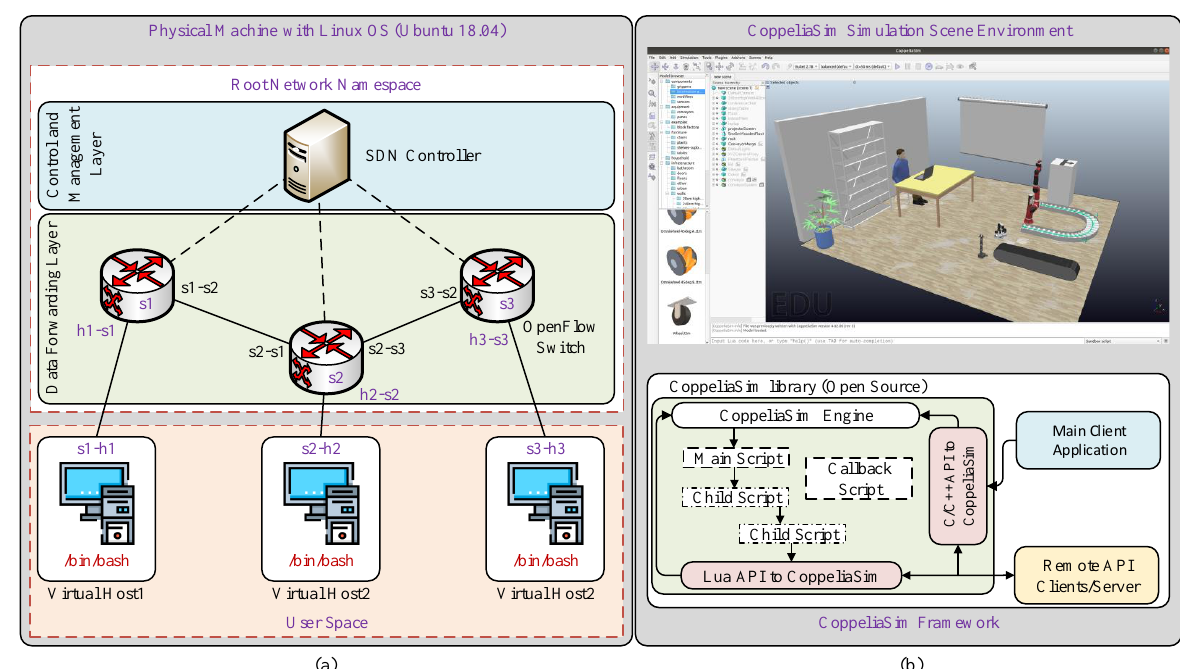
Figure 5. Overview of the basic framework for Mininet and CoppeliaSim. ( a ) represents the Mininet network emulator with Open vSwitch and SDN based OpenFlow protocol, ( b ) illustrates the CoppeliaSim simulator scene environment along with control